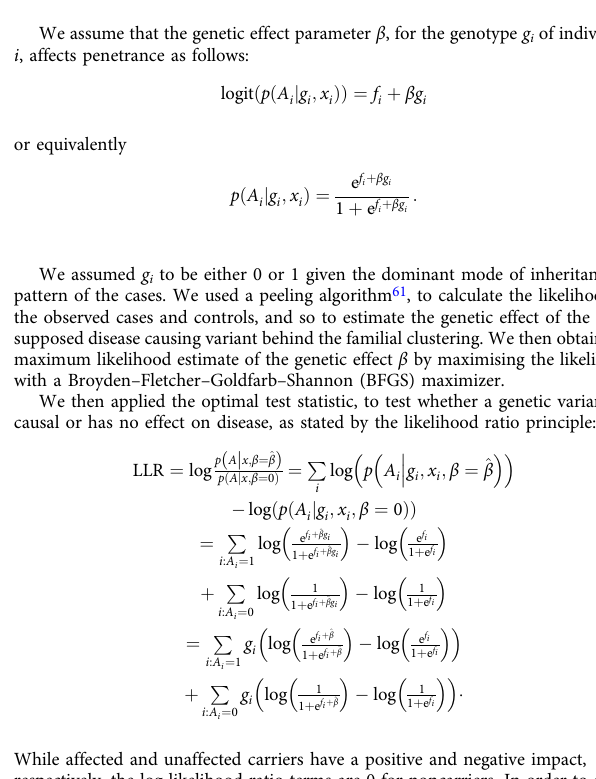
The MAP1B-FS and Control-FS are unadjusted mean and standard deviation (SD) MRI white matter volume (mm 3 ) and grey matter volume (mm 3 ), surface area (mm 2 ) and thickness (mm) values derived from FreeSurfer (FS). Individuals ’ FS values were inverse normal transformed and adjusted for sex, age, age 2 , scanner model and ICV where appropriate. The effect ( β in SD) and P -value were calculated by comparing MAP1B LoF carriers ( n = 10; FAM1-B1,-C1,-C2,-D1,-D2,-D3, FAM2-H1,-J1,-J2, FAM3-L1) with controls ( n = 949) using a generalised least-squares regression with a variance – covariance matrix based on the kinship coef fi cient of each pair of individuals. See Supplementary Data 1 for the full list of 274 traits. Bonferroni signi fi cance level was set at 0.05/274 = 1.8×10 − 4 LH: left hemisphere, RH: right hemisphere, SD: standard deviation, FS: